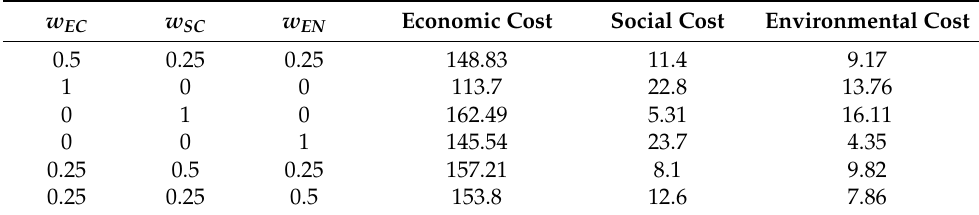
Table 6. Effect of changes in the weights of the three objective functions on economic, social, and environmental costs (in 1000$).